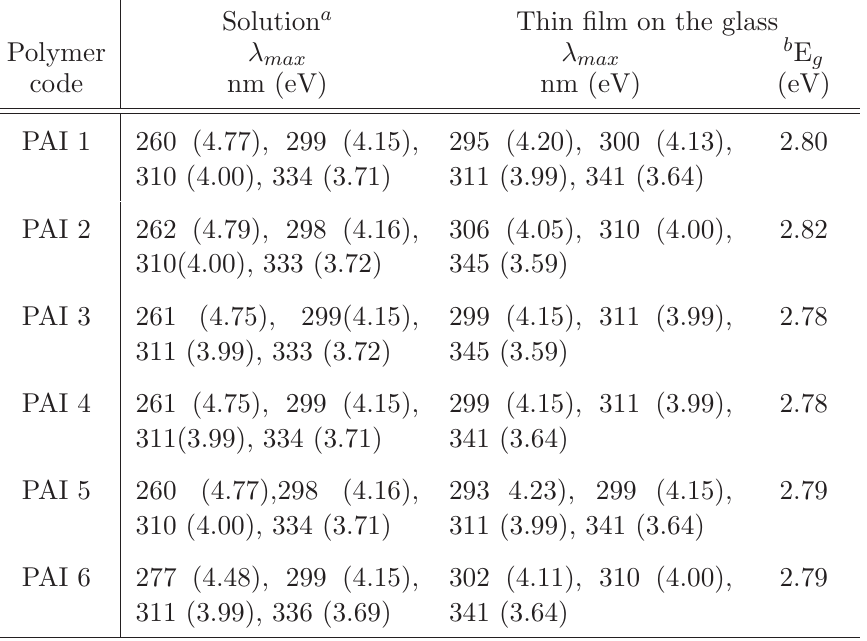
Fig. 3 UV-visible absorption spectra of PAI 5 (a) in thin film on glass (thickness around 100 nm) and (b) in NMP solution with a concentration of 1 × 10 − 5 mol/L. Table 3 The UV-Vis absorption data of poly(amideimide)s both in solutions and in films. Solution a Thin film on the